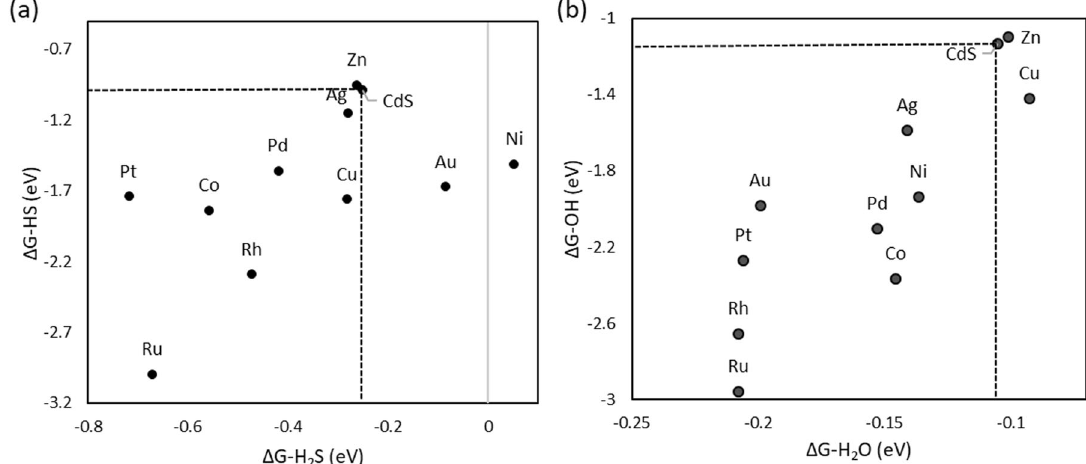
Fig. 6 Adsorption energies on thepristine CdS (110) surface and TM@CdS surfaces. Gibbs free energies ( Δ G) for H 2 S and HS ( a ), and energies for H 2 O and OH ( b ). The dashed line was set to compare the results of TM@CdS systems with pristine CdS surface. Data are available in